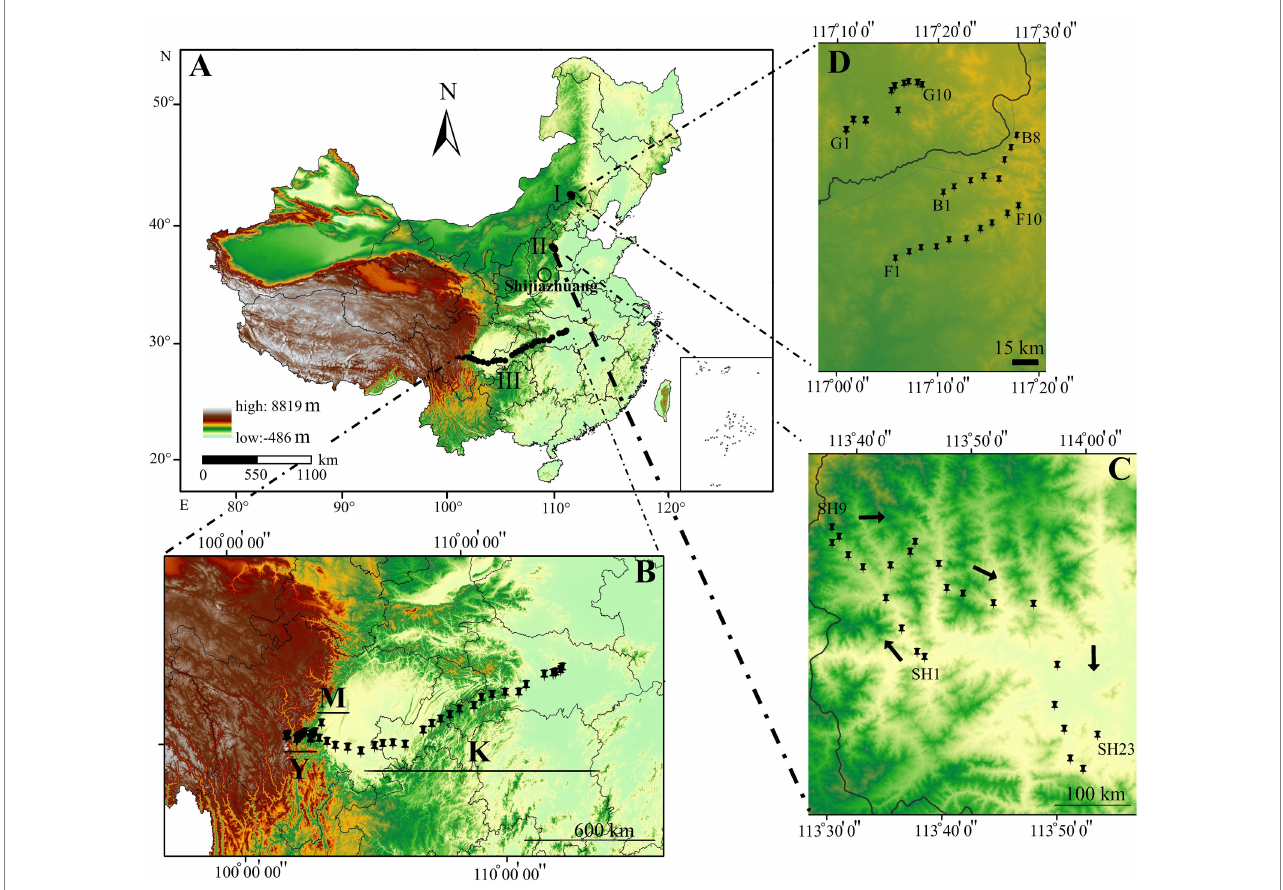
FIGURE 1 Map of China based on the elevational pattern (A) . Sampling sites from Saihanba National Forest Park (SNFP) (B) . Sampling sites on the Taihang Mountains (C) . Sampling sites from Kangding: 29 ° 49 ′ 516 ″ N, 102 ° 54 ′ 276 ″ E, elevation ~3,100 m above sea level) and central Sichuan Province to southeastern Hubei Province (Ping Ke Xian: 31 ° 06 ′ 962 ″ N, 113 ° 15 ′ 18 ″ E, elevation 100 m above sea level) (D) . The black dots indicate the sampling path from Sichuan Province to Hubei Province. The geographical map with coordinates was created by ArcGIS for Windows 10.2 (Environmental Systems Research Institute (ESRI; www. esri.com; 2012). B indicates boundaries between forest and grassland at SNFP; G, grasslands at SNFP; F, forests at SNFP; SH, the Taihang Mountains; K, Meishan to Ping Ke Xian; Y, Ya’an area; and M, Meishan